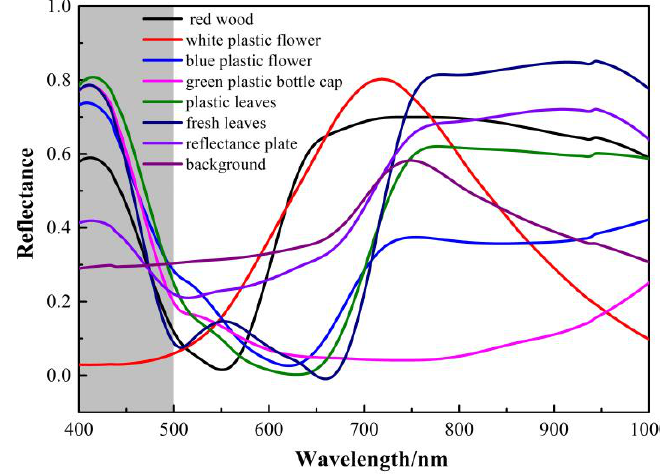
Figure 5. The mean spectra of different objects in the ROIs selected for analysis.